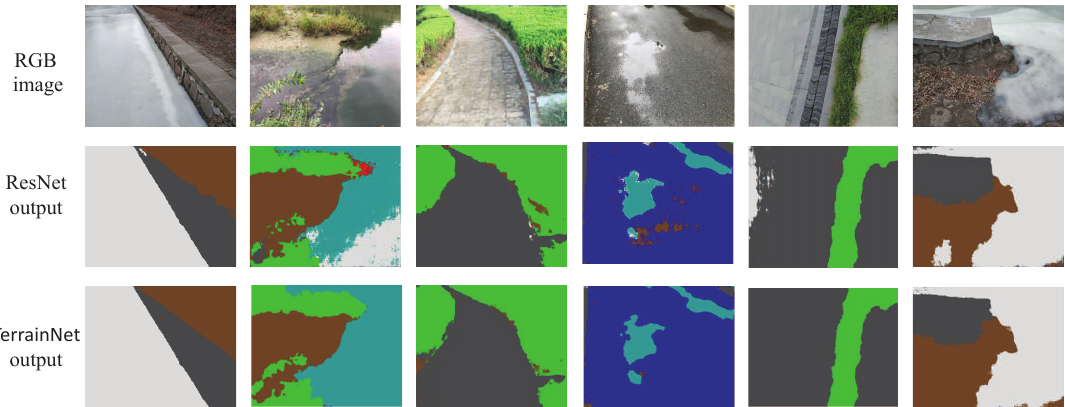
Figure 14. Comparison of semantic segmentation between ResNet-101 and TerrainNet. The second row is the prediction output by ResNet-101, and the third row is the prediction output by TerrainNet. The segmentation effect of the third row is better than that of the second row.